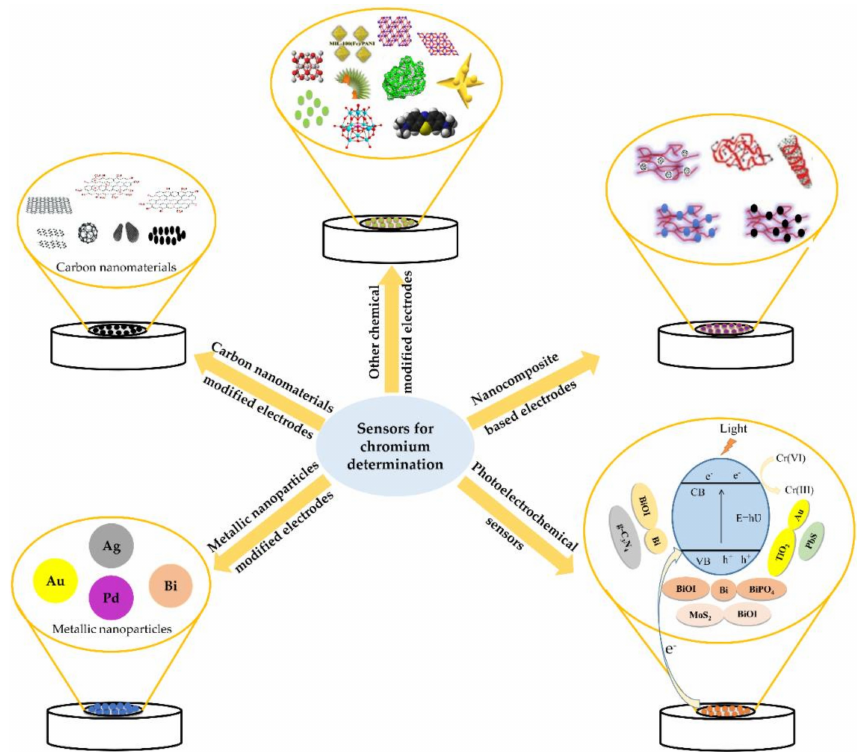
Figure 2. Scheme of di ff erent utilized nanomaterials for chromium